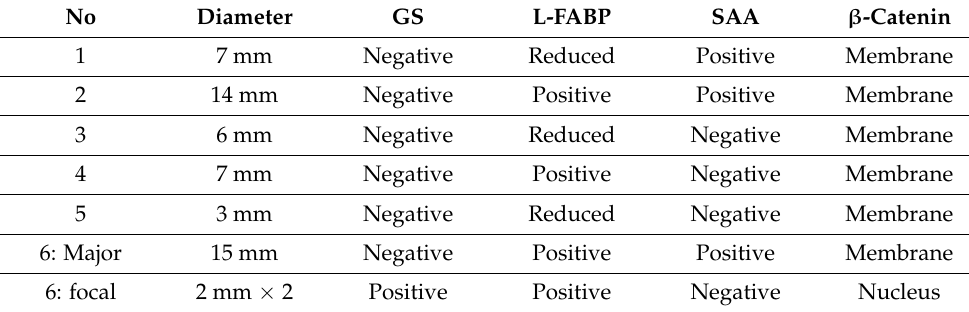
Table 1. Characteristics of GS-negative tumors.